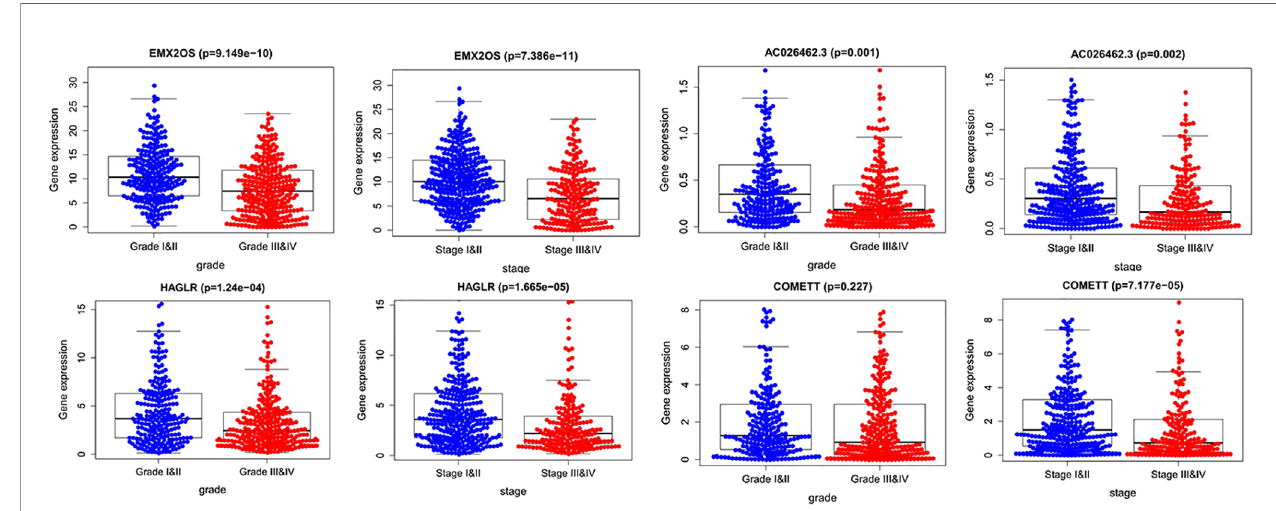
FIGURE 7 | The expression of the four-signature lncRNAs between high grade and low grade, advanced stage, and early